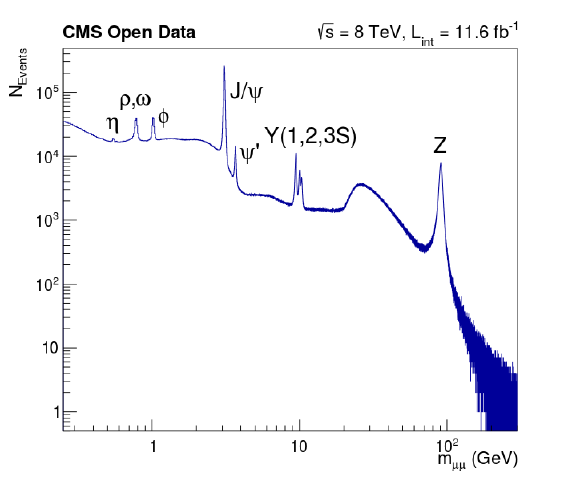
Figure 1. Analysis of the di-muon spectrum using data from the CMS detector taken in 2012 [19].